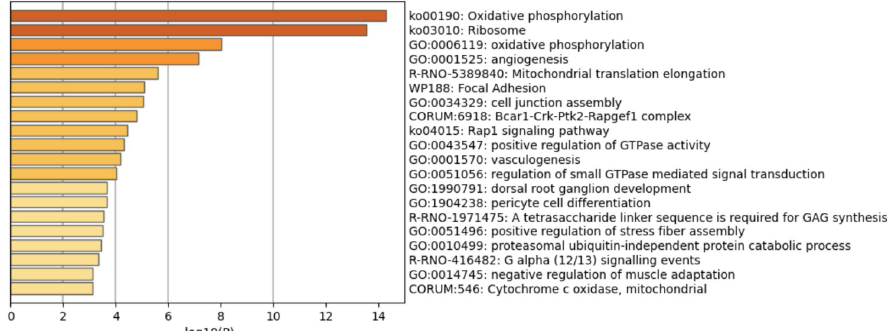
Fig 12. Enrichment result of the 345 DEG that manifest at the late timepoints. This figure presents the GSEA results for the 345 consistently up-/down-regulated DEG defined between the ISO vs. na ï ve rats at Days 240 and 360. The X-axis is the negative log-transformed p-value of the enriched terms. The darker the color, the more statistically significant the enriched term (pathways, GO terms, etc.). Groups of rats exposed to air (na ï ve, n = 6/each timepoint group) or ISO (n = 5/Day 1 group, and n = 6/Day 30, 240, and 360 groups) were used.